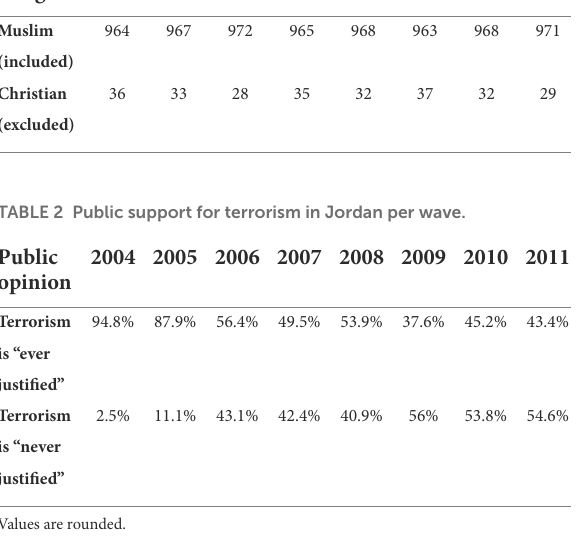
TABLE 1 Overview of the number of responses per wave based on respondents’ religion.